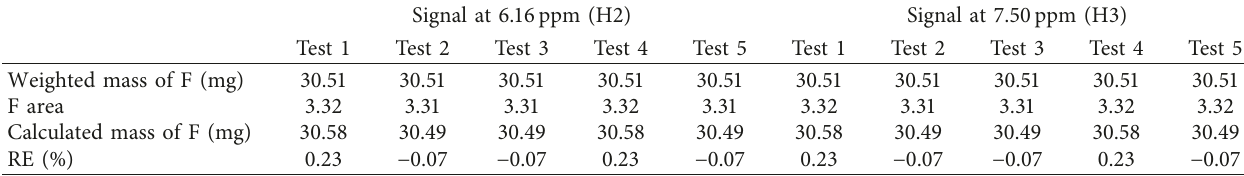
Table 3: Precision of 5-hydroxymethyl-2(5H)-furanone (F) measurements by 1 H NMR. Signal at 6.16ppm (H2)